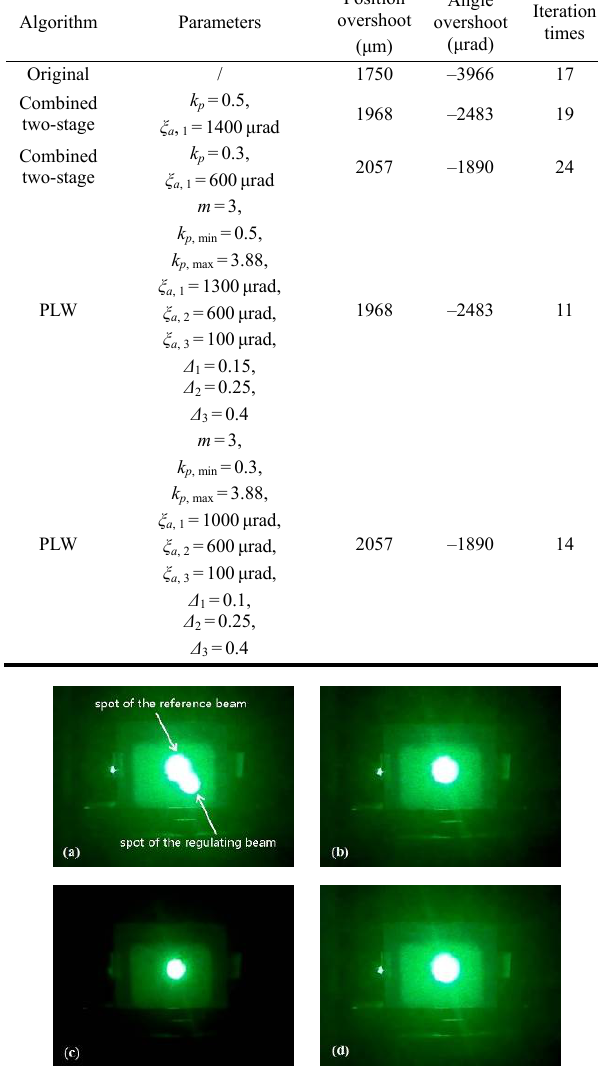
Fig. 7 Spots of the reference beam and regulating beam on the screen: (a) shows the spots before the alignment, (b) shows the spot of the reference beam on the screen in the reference beam path, (c) shows the spot of the regulating beam after the beam alignment in the X and Y directions, and (d) shows the overlapping spots when S2 are removed after the